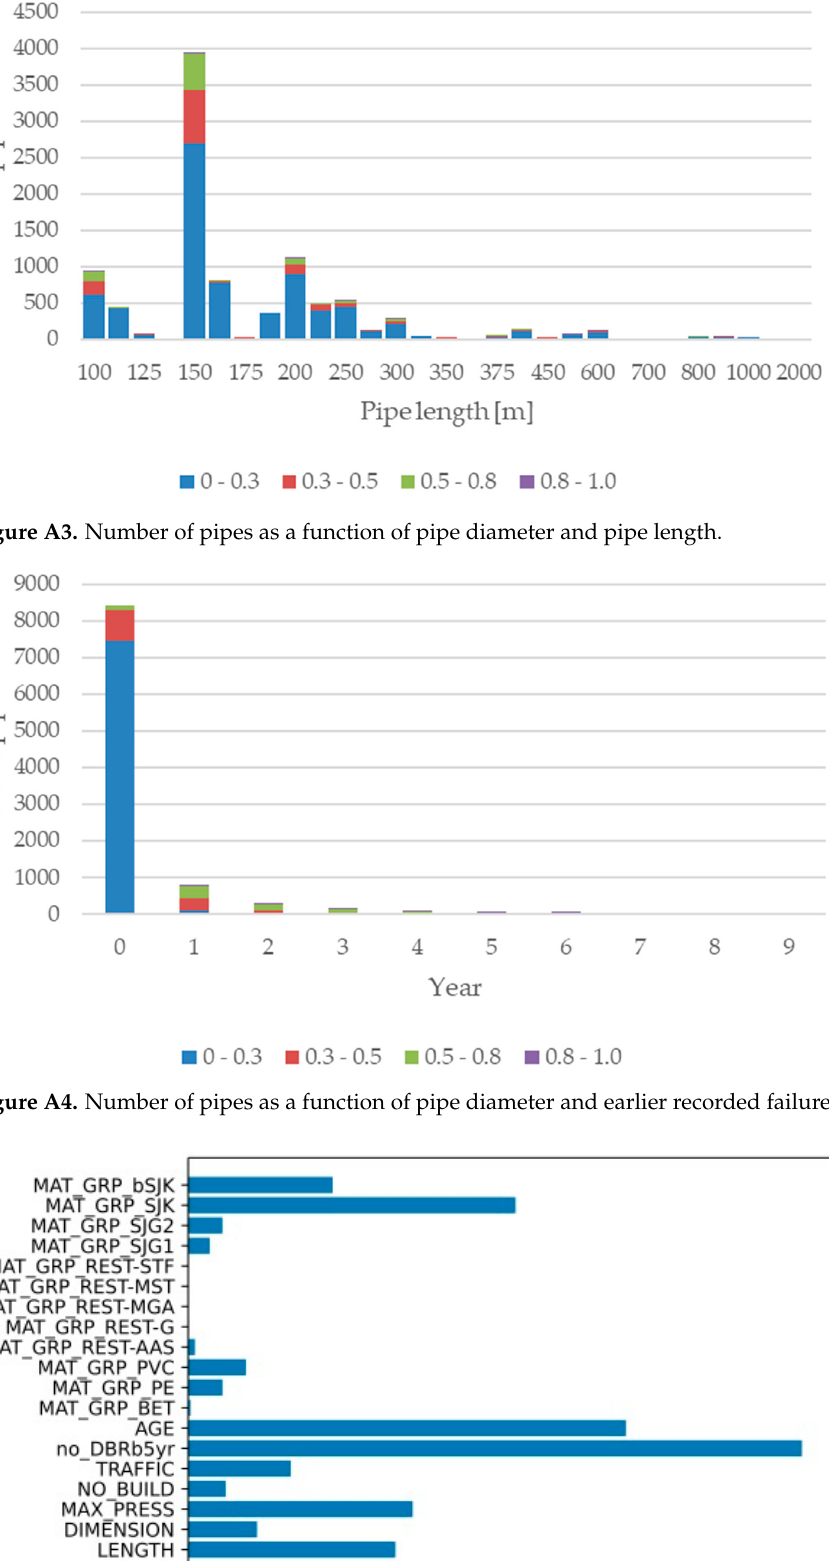
Figure A2. Number of pipes as a function of pipe diameter and installation year.